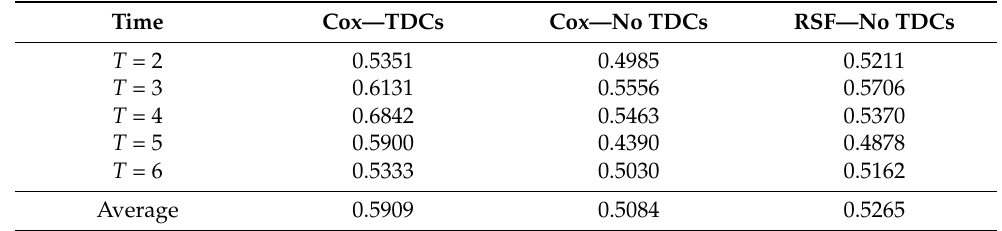
Table 7. Area under the curve (AUC) for Cox models and RSF with and without time-dependent covariates (TDCs), by time intervals (N =